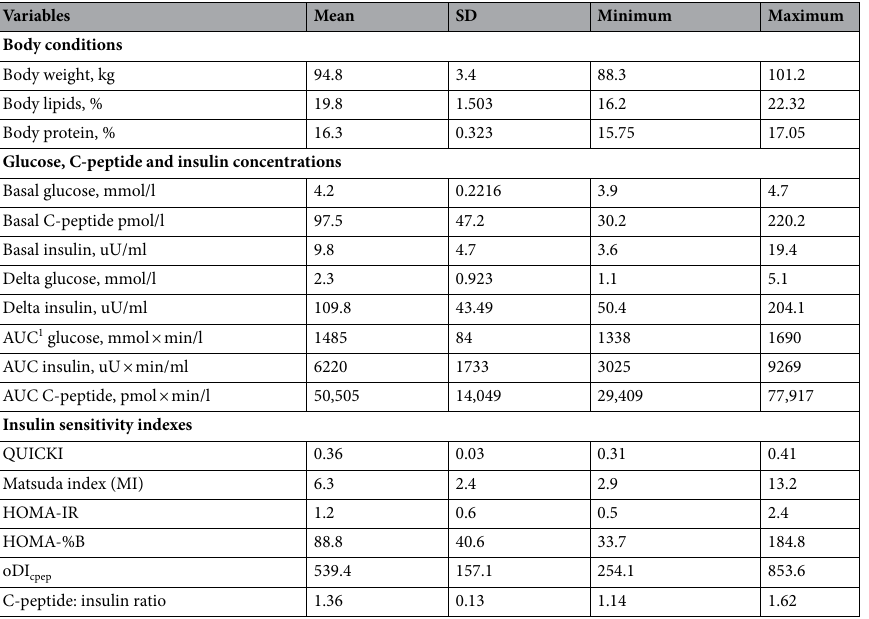
Table 3. Descriptive statistics of the body composition, plasmatic glucose, plasmatic C-peptide, plasmatic insulin and insulin sensitivity indexes of pigs (n = 24) participating in the oral glucose tolerance test (trial 1). AUC Area under the curve, QUICKI quantitative insulin sensitivity check index, oDI cpep oral disposition index, HOMA-IR homeostasis model assessment for estimating insulin resistance, HOMA-%B homeostasis model assessment for estimating β-cell function. 1 Area under the curve of plasmatic glucose or insulin concentrations obtained from time 0 to 360 during the oral glucose tolerance test